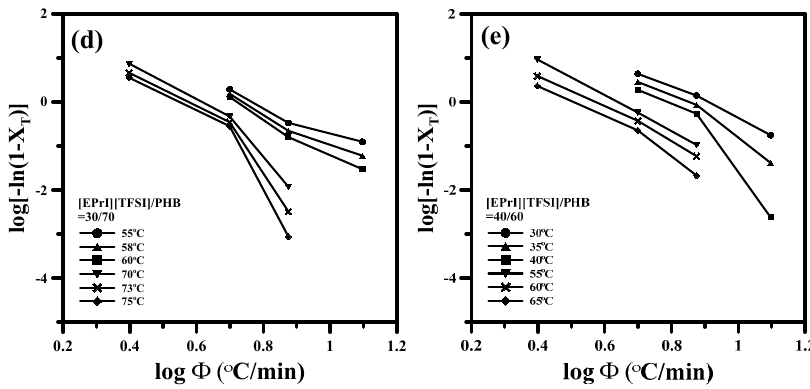
Figure 8. Ozawa plots of log[ − ln(1 − X T )]-v.s.-log Φ for the non-isothermal crystallization of [EPrI][TFSI]/PHB blends with different compositions: ( a ) 0/100; ( b ) 10/90; ( c ) 20/80; ( d ) 30/70; and ( e ) 40/60.